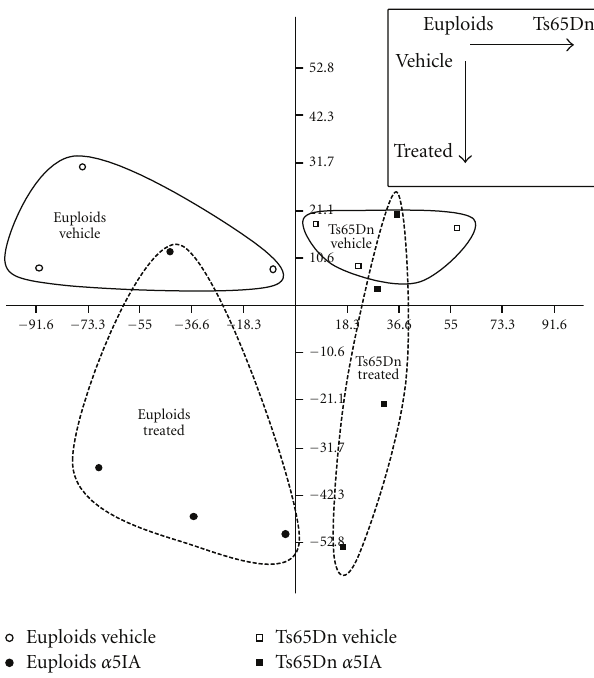
Figure 5: PCA on IEGs expression measured on microarrays. The first principal component fully discriminated euploid and Ts65Dn mice. The second principal component partially discriminated vehicle- and α 5IA-treated